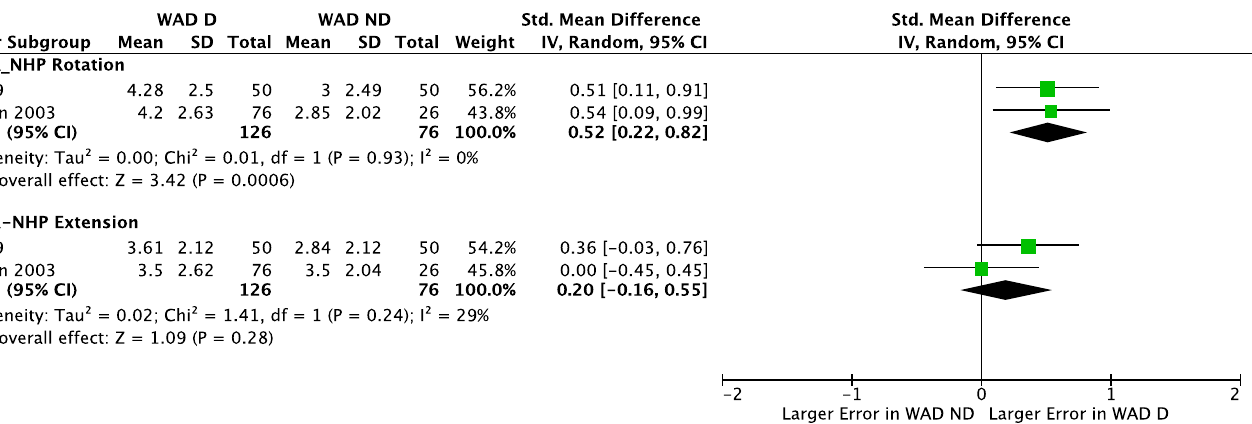
Fig 4. Forest plot demonstrating meta-analysis of absolute error (in degrees) of JPS when repositioning the head to neutral-head-position from extension and rotation in WAD D group vs. WAD ND group. WAD D : whiplash-associated disorder presenting with dizziness; WAD ND : whiplash-associated disorder not presenting with dizziness; SD: standard deviation; IV: inverse variance; CI: confidence interval; Std: standardized.